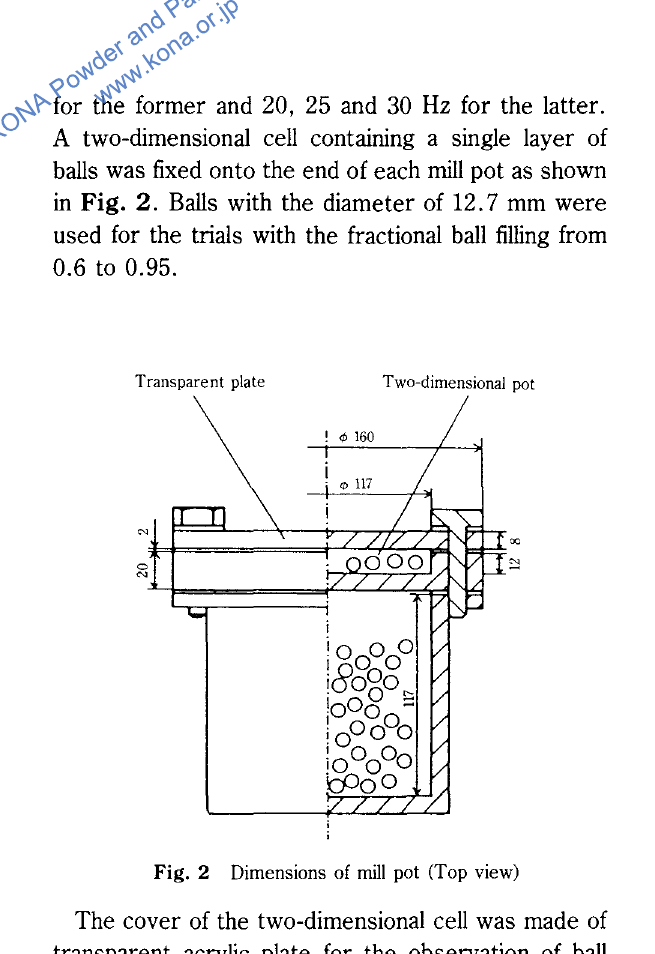
Fig. 2 Dimensions of mill pot (Top view)